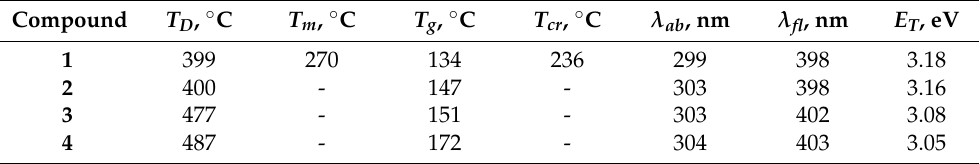
Table 1. Thermal and photophysical characteristics of compounds 1 – 4 .